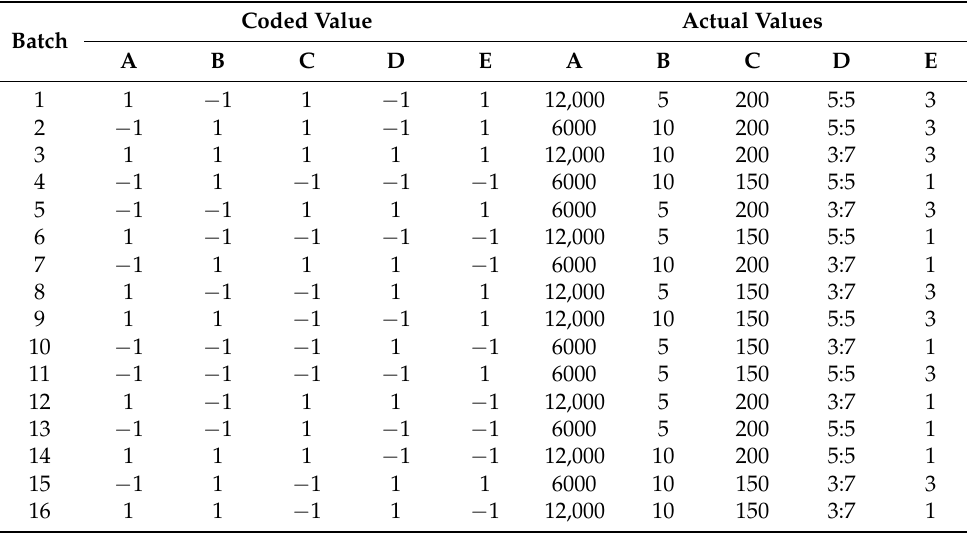
Table 2. Coded and actual values of fractional factorial design batches.